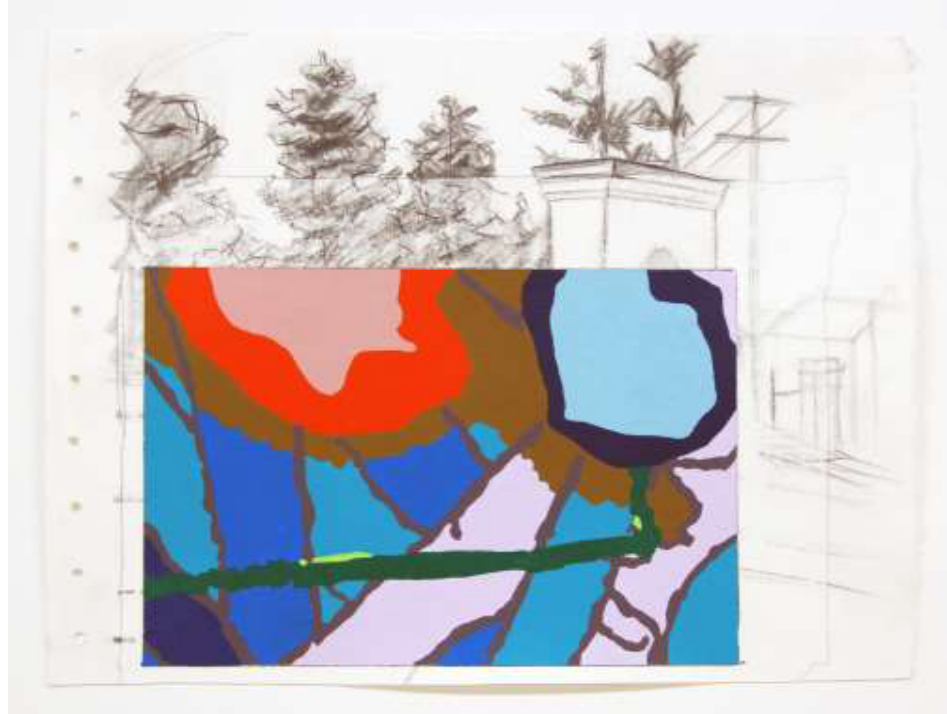
Steven Pearson, Sketchbook Revisions: The Arch , 2014, graphite and acrylic on Rives BFK, 12 x 9